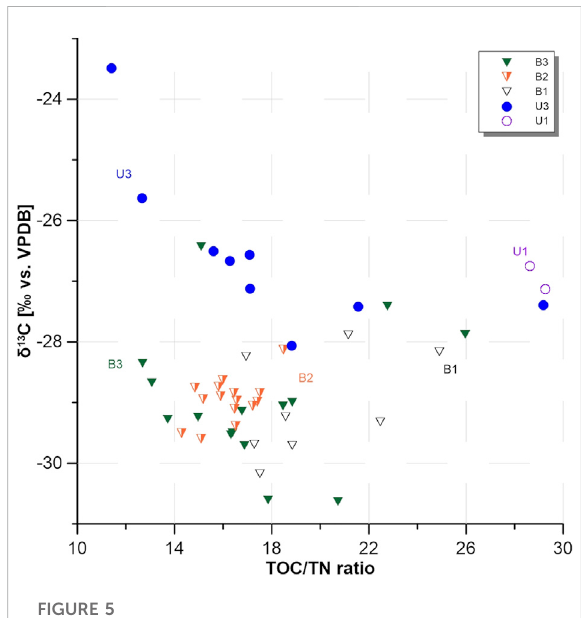
FIGURE 5 Total organic carbon to total nitrogen (TOC/TN) ratios plotted against the stable carbon isotope ( δ 13 C) ratios of all sampling